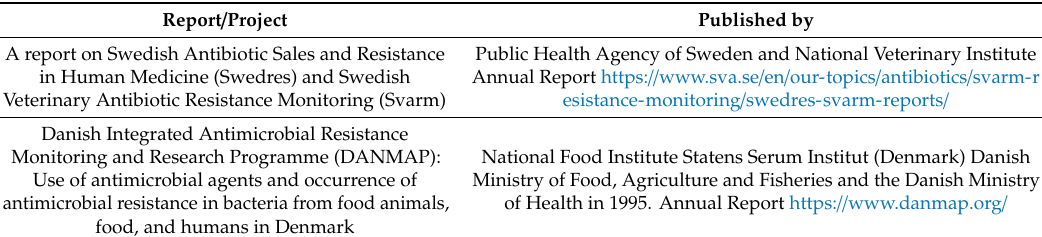
Figure 1. Actions for reduction of microbial resistance to drugs (based on available reports, literature, and the RONAFA (European agencies) opinion. Table 1. International programs and organizations participating in global or local efforts to reduce drug resistance (data available in English).